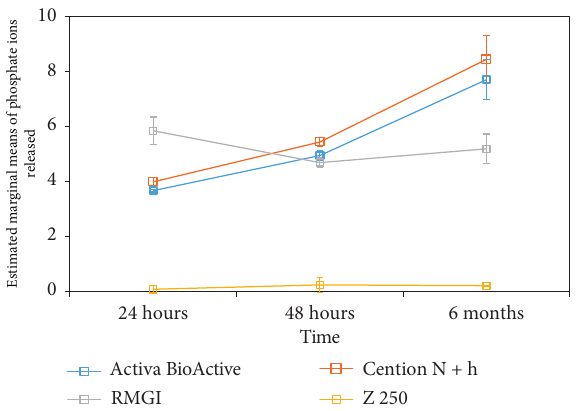
Figure 1: Comparison of the mean values change in phosphate ion release ( μ g/cm 2 ) from the stored restorative materials following pH reduction from 6.8 to 4 at different time points.